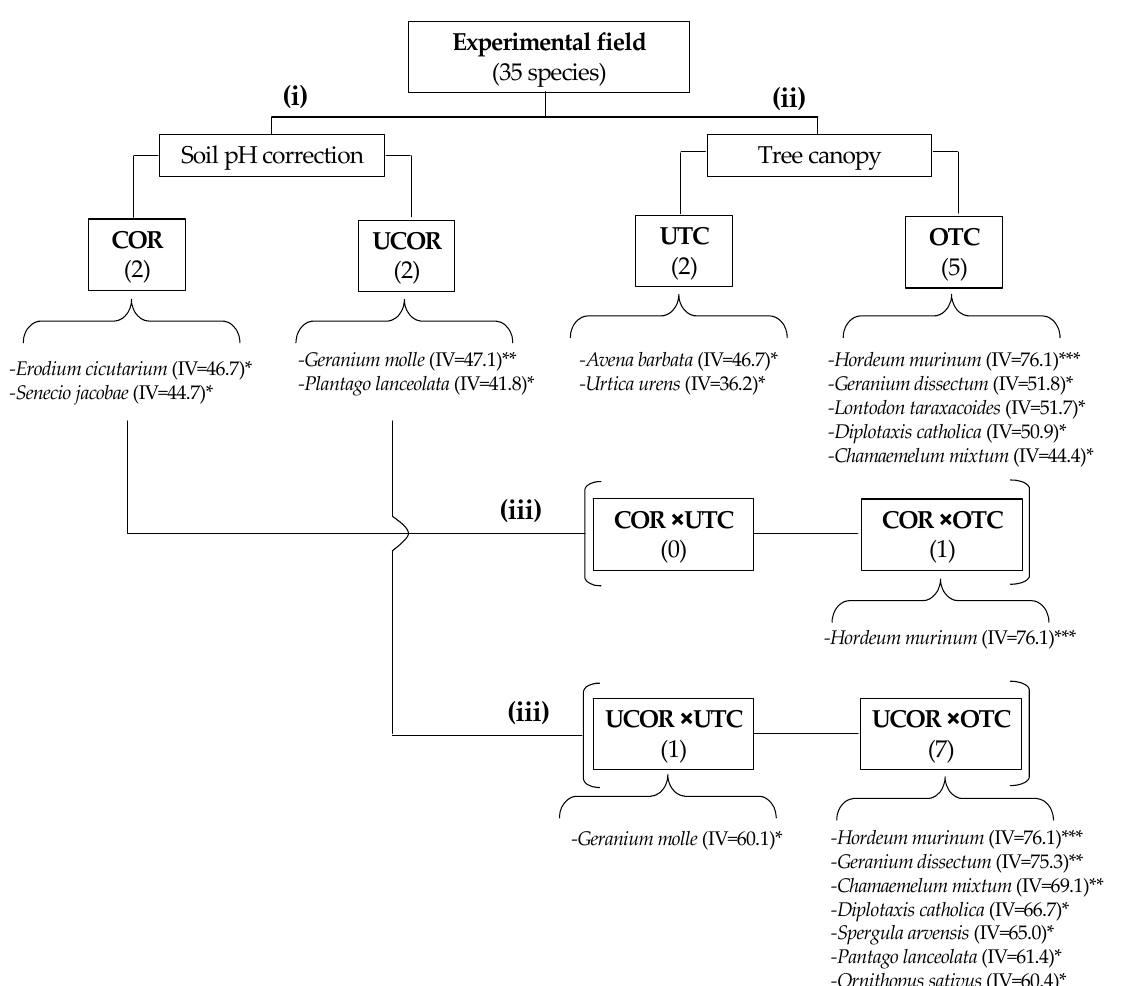
Figure 10. Dendogram representing the results of ISA in three approaches: (i) soil pH correction factor, (ii) tree canopy factor and (iii) combination of the two previous factors. COR—Amended area; UCOR—Unamended area; UTC—Under tree canopy; OTC—Outside tree canopy; IV—Indicator value; ***—Probability < 0.001; **—Probability < 0.01; *—Probability <0.05.